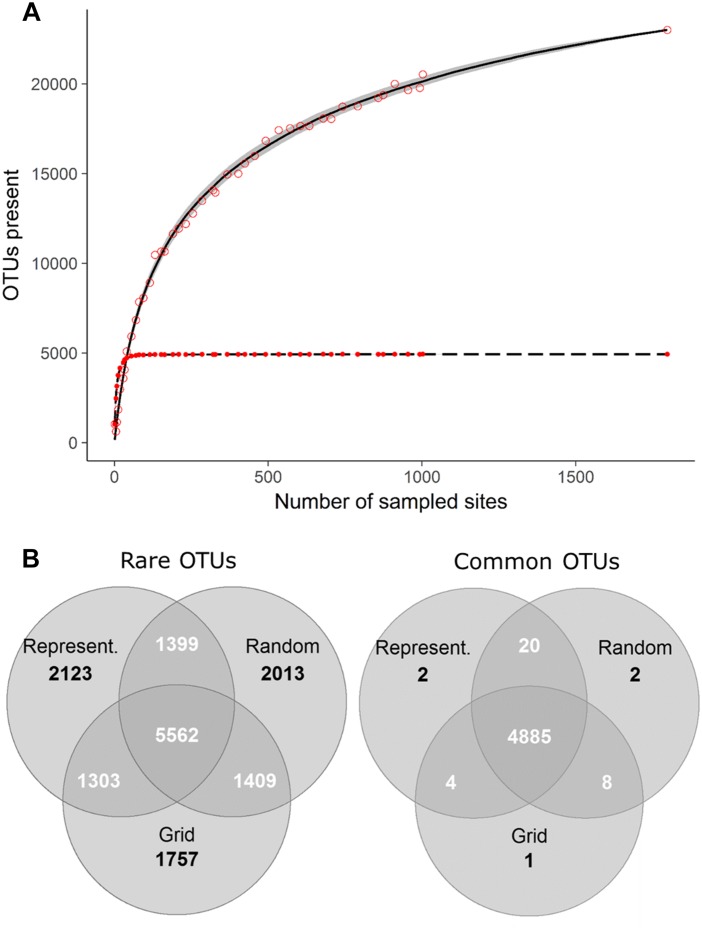
(A) Taxa accumulation curve showing the OTUs detected by the random (lines) and grid (points) sampling approaches. The lines indicate the number of rare (>0.001% of total reads; solid line) and common (<0.001% of total reads; dashed line) OTUs detected with increased random sampling; 100 permutations were used, with sites added in a random order, to calculate average values. Standard deviations are indicated in gray. Red points indicate the number of rare (hollow points) and common (filled points) OTUs detected with decreasing grid size (and therefore increased sampling intensity). (B) The number of unique and shared OTUs detected by the different sub-sampling approaches.